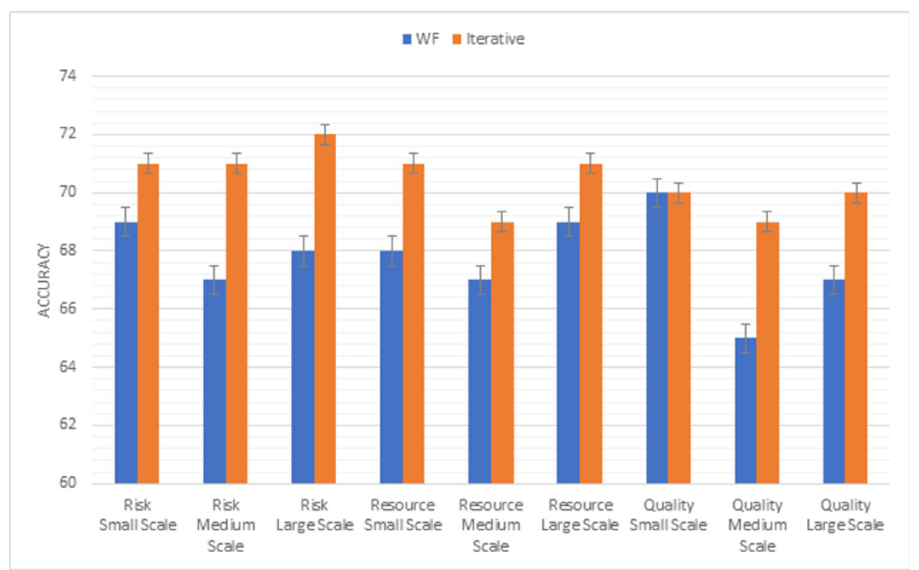
Fig 8. Graphical representation of waterfall vs iterative (second triangle) results.